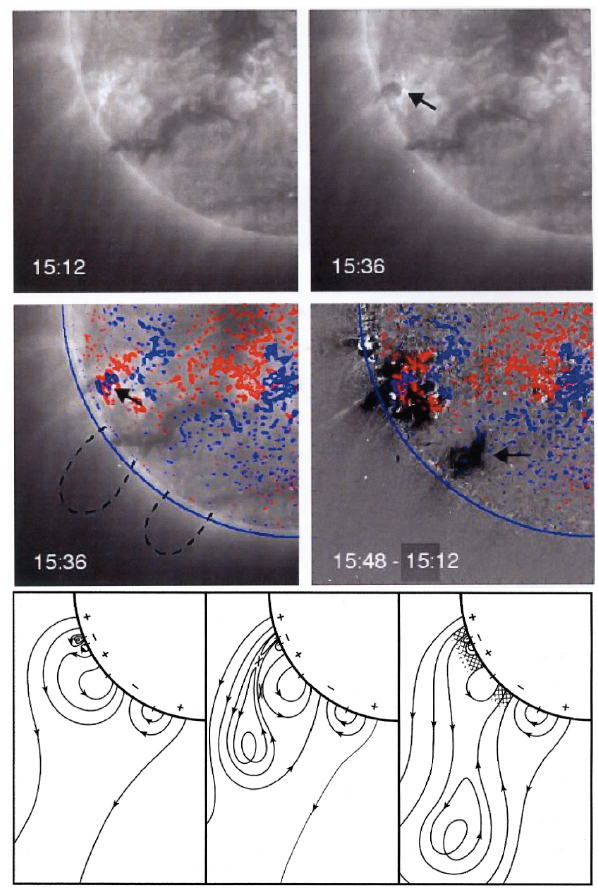
Fig. 9. From Moore and Sterling (2007) showing how a compact eruption (indicated by an arrow in the upper panel) occurring close to a streamer’s base, through magnetic reconnection with an adja- cent magnetic arcade, leads to a laterally more extended CME and the appearance of remote coronal dimming. In the middle panel magnetic polarities are indicated by red and blue contours, support- ing the reconnection scenario (SOHO/EIT images and MDI mag- netic